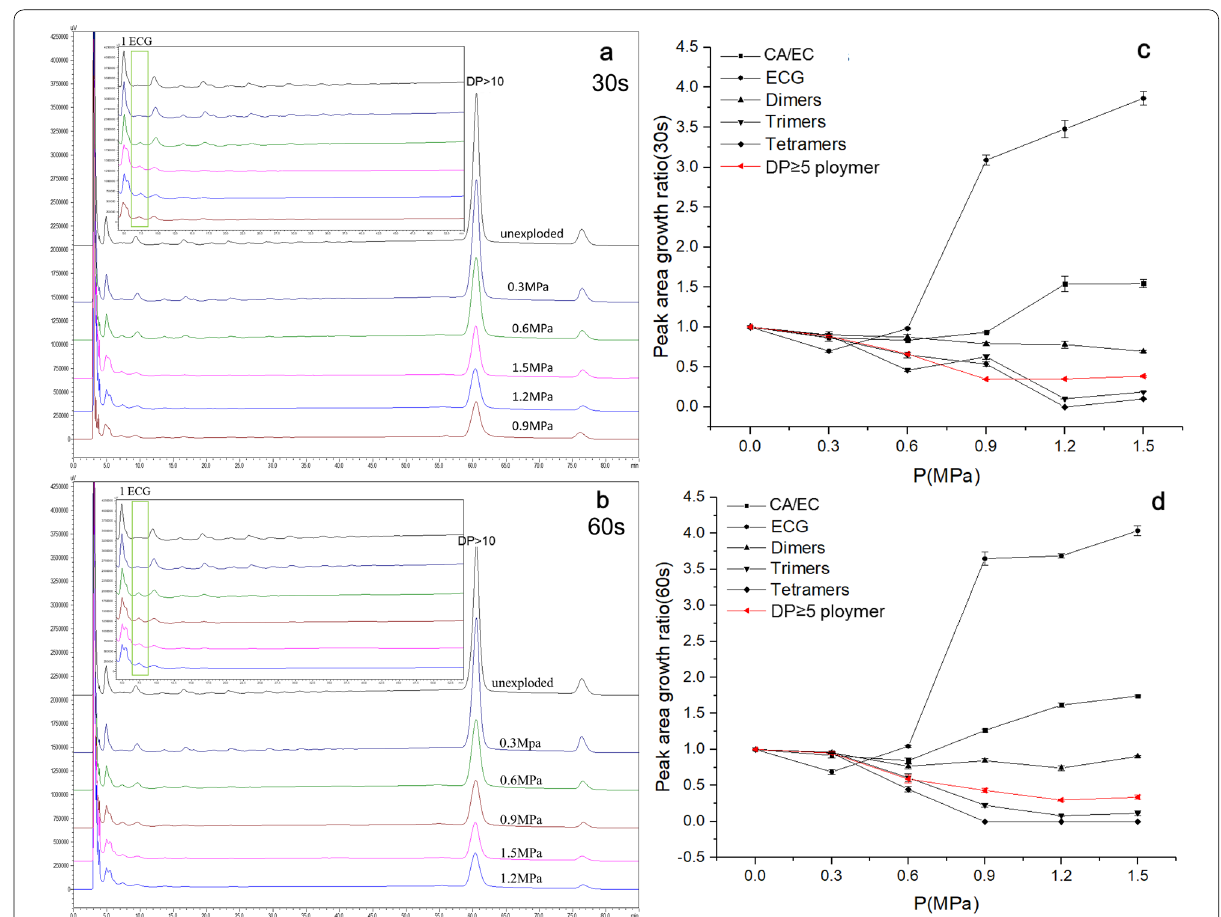
Fig. 5 NP-HPLC chromatogram of procyanidins extracted from unexploded and SE-treated grape seeds ( a , b ) and the PAGR of unexploded and SE-treated grape seeds ( c , d